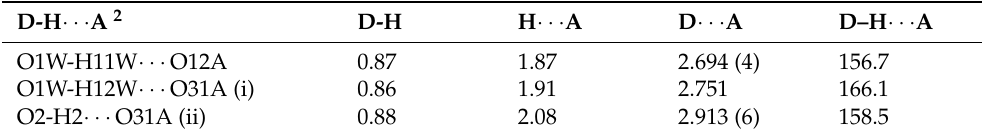
Table 2. Intramolecular hydrogen bonding interactions (Å, ◦ ) of 2D layers 1 .